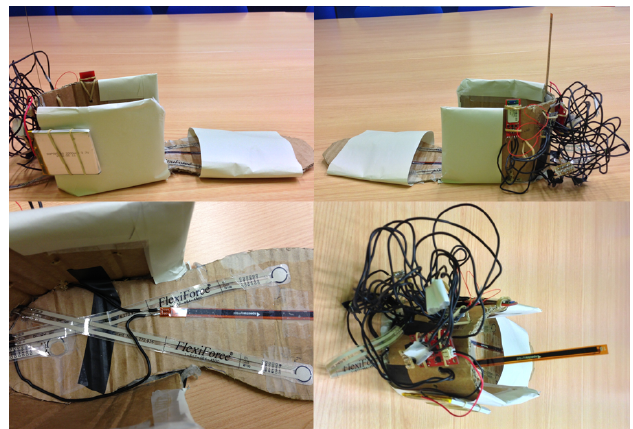
Figure 16. First shoe